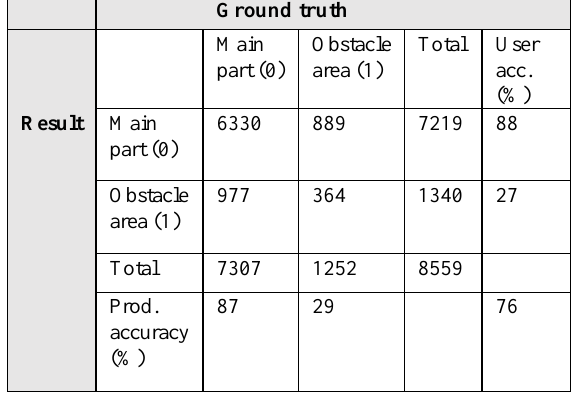
Table 1 . Contingency matrix for a sample building, using the